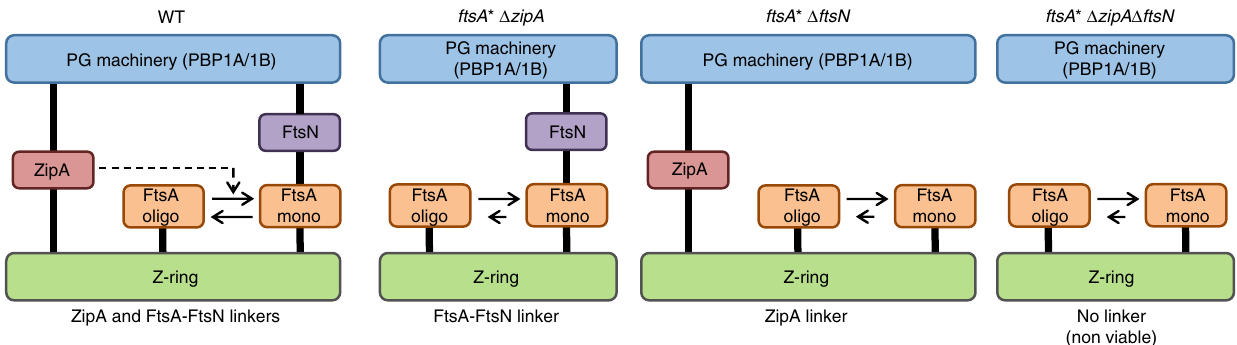
Fig. 6 Model for preseptal PG synthesis in the presence or absence of ZipA. FtsZ, ZipA and either PBP1A or PBP1B are essential for preseptal PG synthesis. The cytosolic FtsZ ring (Z-ring) and the PG synthases are linked at early stages of cell division by ZipA and by FtsA-FtsN. ZipA promotes monomerization of FtsA, which is needed to obtain the FtsA – FtsN complex. In the presence of FtsA* (FtsA mutants impaired in dimerisation) the interaction between FtsA* and FtsN is enhanced, rendering ZipA dispensable and FtsN essential to link the Z-ring and the PG synthesis machinery. In the absence of FtsN, ZipA becomes the only linker between both cytosolic and periplasmic proteins. When both ZipA and FtsN are absent the link is lost, leading to non-viable cells. The cell membrane is not shown in this